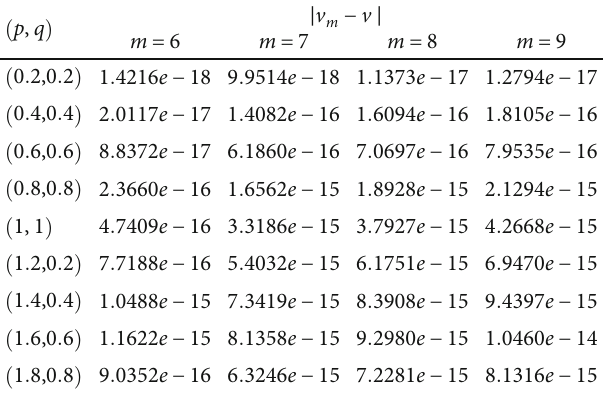
Table 8: The absolute error for di ff erent values m for Example 9 at various points ð p , q Þ .